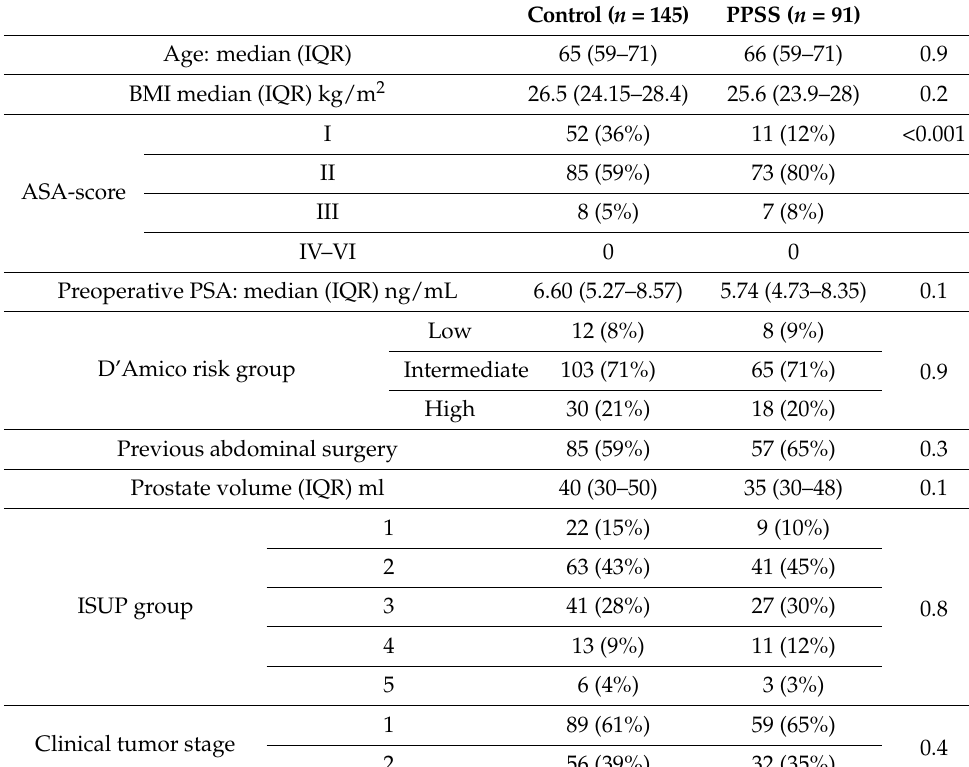
Table 1. Patient